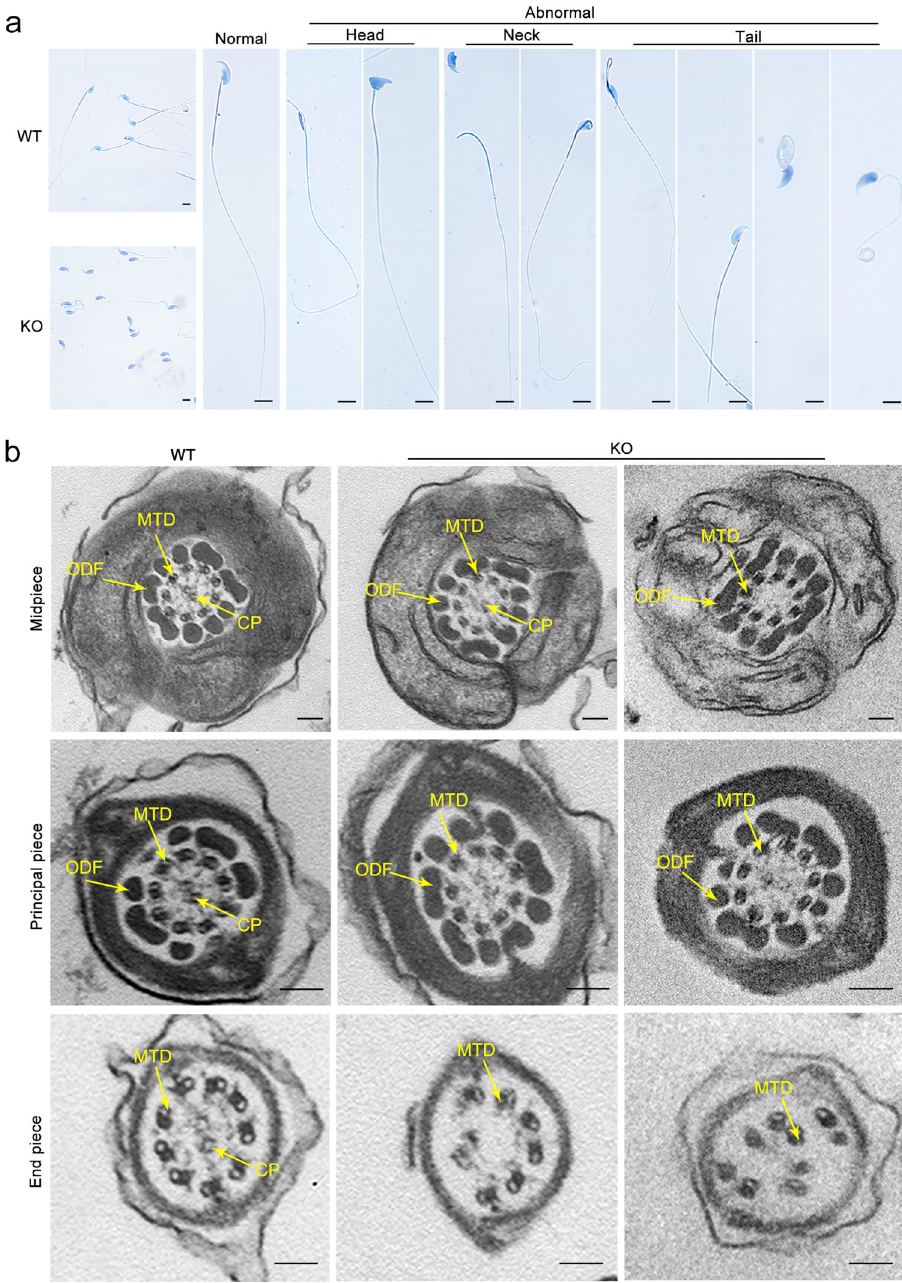
Fig. 5 Anomalies in the morphology and ultrastructure of spermatozoa from male Cep128 KO mice. a Spermatozoa from male KO mice showed prominent deformities in the head, neck, and tail regions under light microscopy ( n = 3 biologically independent WT mice or KO mice; scale bars, 20 µ m). b The primary defect in the midpiece and principal pieces was the absence of the CP, while missing and misplaced MTDs were observed in the end piece. CP central-pair microtubules, MTD peripheral microtubule doublets. ( n = 3 biologically independent WT mice or KO mice; scale bars, 150